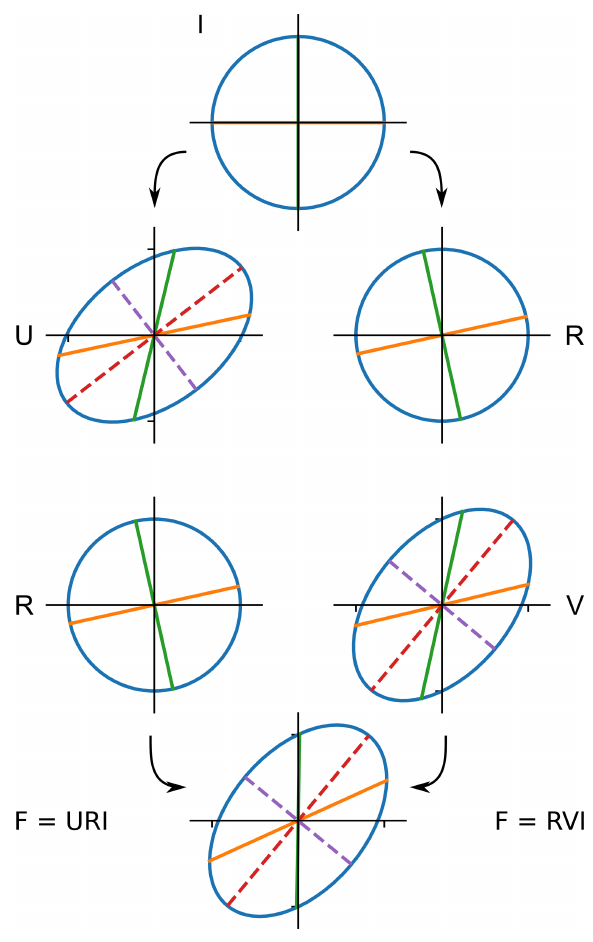
Figure 11. Polar decomposition of the deformation gradient tensor F into a finite rigid-body rotation tensor R and either a left-stretch tensor V or right-stretch tensor U . I is the identity matrix. Note that F and V have the same orientations of their principal components. The green and orange lines are initially parallel to the axes of the Cartesian reference frame and here illustrate the rotation of the unit circle (top). The dashed lines are the long and short axes of the deformation